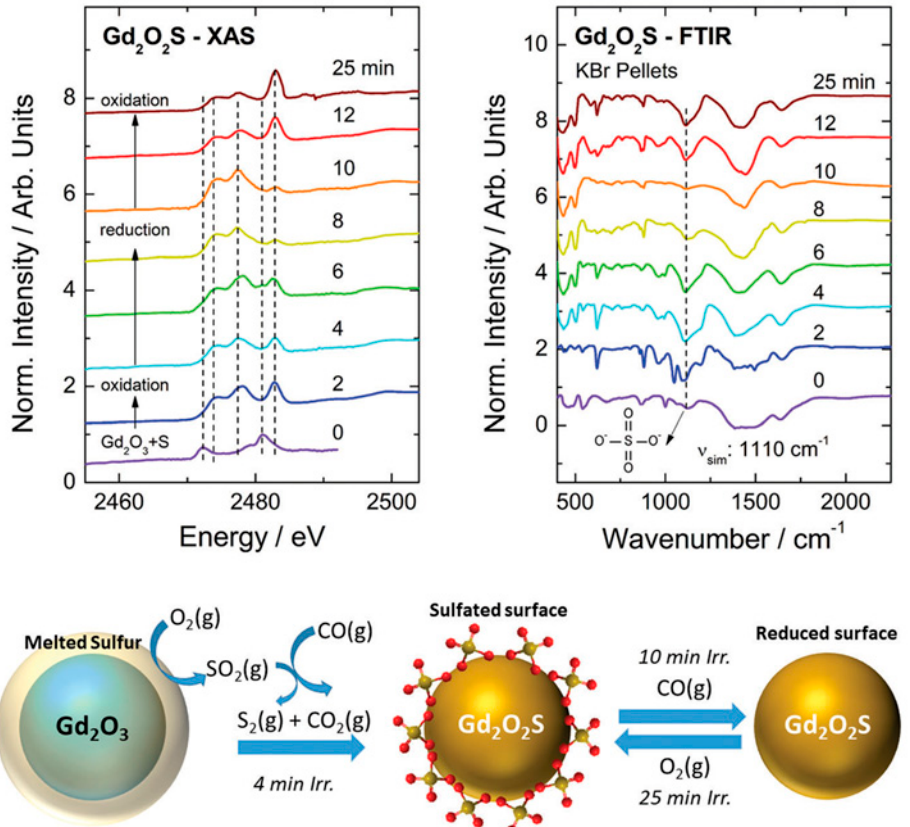
Figure 14. SR-XANES of the sulfur K-edge ( top left ) and FTIR spectra ( top right ) of the Gd 2 O 2 S materials obtained by the MASS method for different durations of microwave exposure. Schematic representation of oxysulfide formation with the participation of the gases assisting the redox process of sulfur ( bottom ). Reproduced from Ref. [76] with permission from The Royal Society of Chemistry.